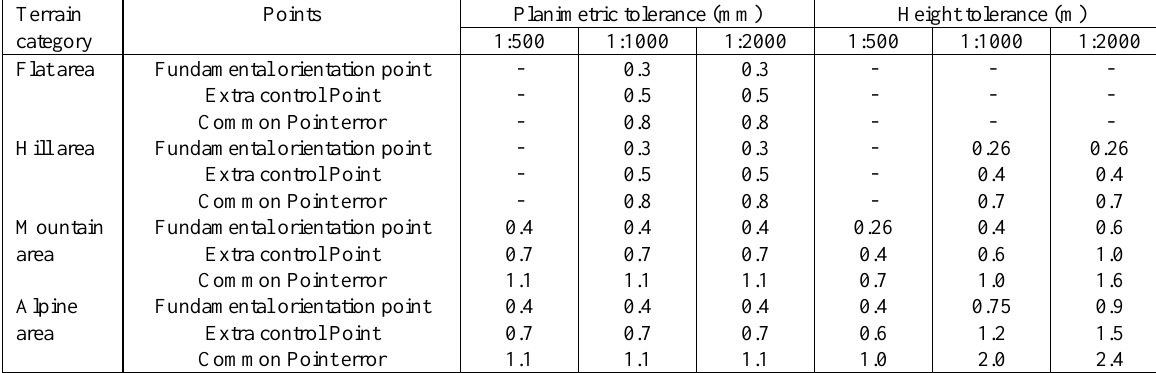
Table 1, accuracies of 1:500